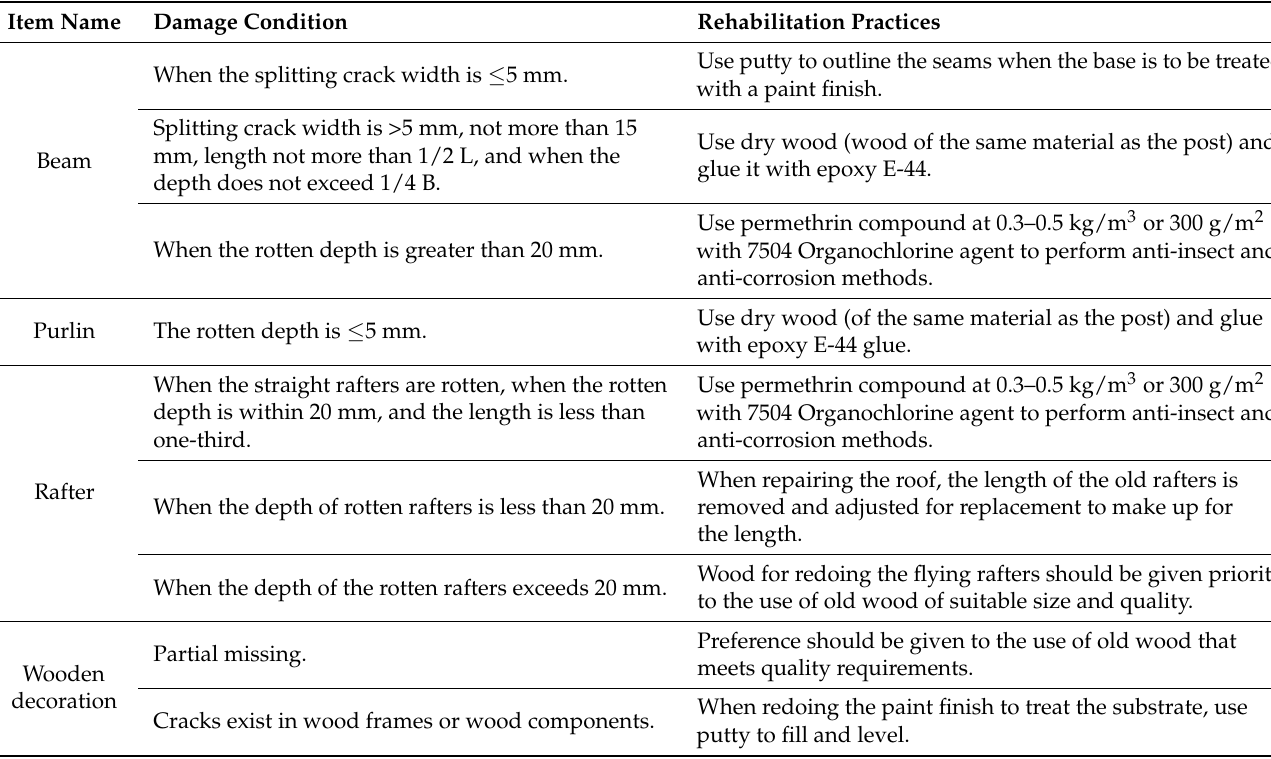
Table A1. Wooden component rehabilitation